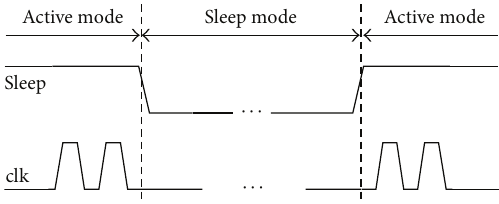
Figure 5: The operation timing of